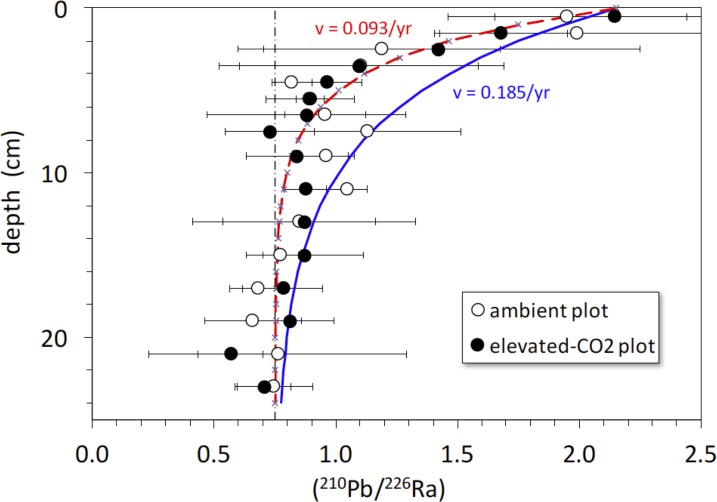
Activity ratio (210Pb/226Ra) vs. depth (cm) in soil cores collected in 2008 from ambient (open circles) and elevated-CO2 (filled circles) plots at the Oak Ridge FACE site.Solid curve (blue) represents constant addition of 210Pb to the surface, an advection rate of 0.185 cm yr−1 based on best-fit of advection-diffusion model (Eq. (3)) to mean 137CS profiles, and decay of 210Pb to a steady-state value of 0.75 × (226Ra), representing 25% loss of in situ
222Rn production. Dot-dashed vertical line represents the typical mean value of 0.75 for soil (210Pb/226Ra) (Graustein & Turekian, 1990). Dashed curve (red) represents constant addition of 210Pb to the surface and an advection rate of 0.0.093 cm yr−1 based on the best-fit of advection-diffusion model (Eq. (4)) to mean unsupported-210Pb profiles, and decay of 210Pb to a steady-state value of 0.75 × (226Ra). Apparent deficiency of excess 210Pb in the soil profiles is consistent with diffusive escape of 222Rn produced in situ, possibly enhanced by bioturbation and transpiration occurring in the shallow root zone.